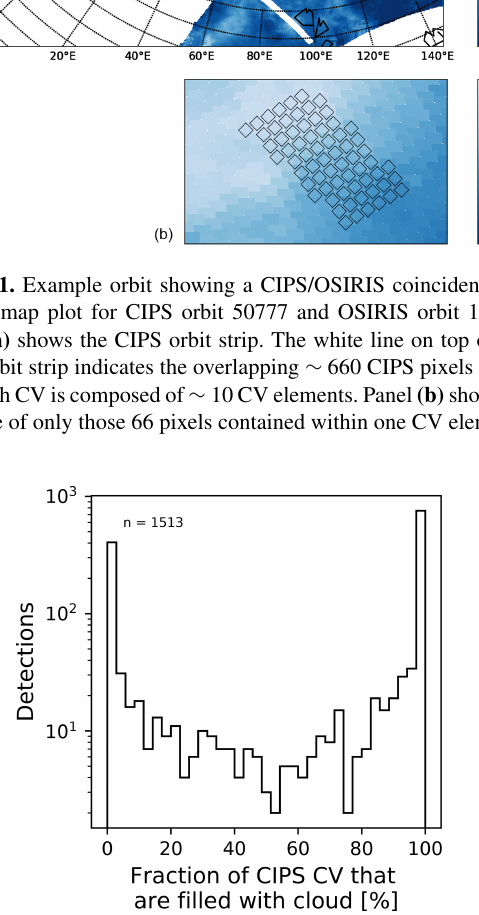
Figure 2. AIM CIPS occurrence of PMCs in the common volume with OSIRIS during the observations in 2010–2011. The plot shows the number of CVs containing a certain fraction of CIPS pixels with identified PMCs. Average latitude is 80 ◦ N, local time ∼ 15 : 45. The mean cloud fraction is